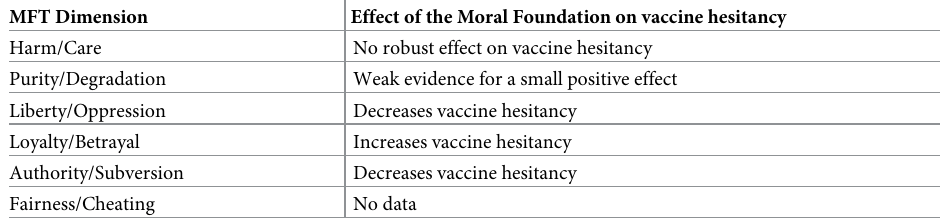
Table 6. Summary of the